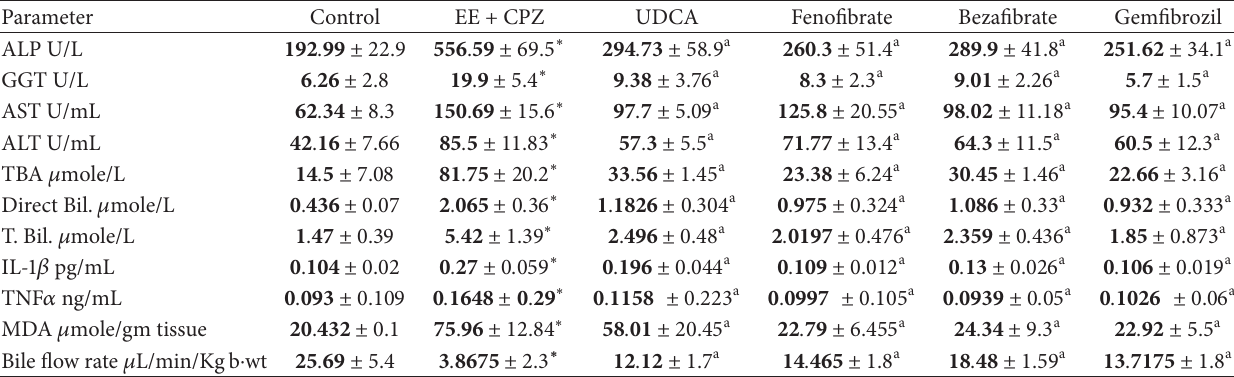
Table 1: Effect of ursodeoxycholic acid, fenofibrate, bezafibrate, and gemfibrozil on serums ALP, GGT, ALT, AST, TBA, direct bilirubin, total bilirubin, IL-1 𝛽 , TNF 𝛼 , and hepatic MDA levels in EE and CPZ treated rats.